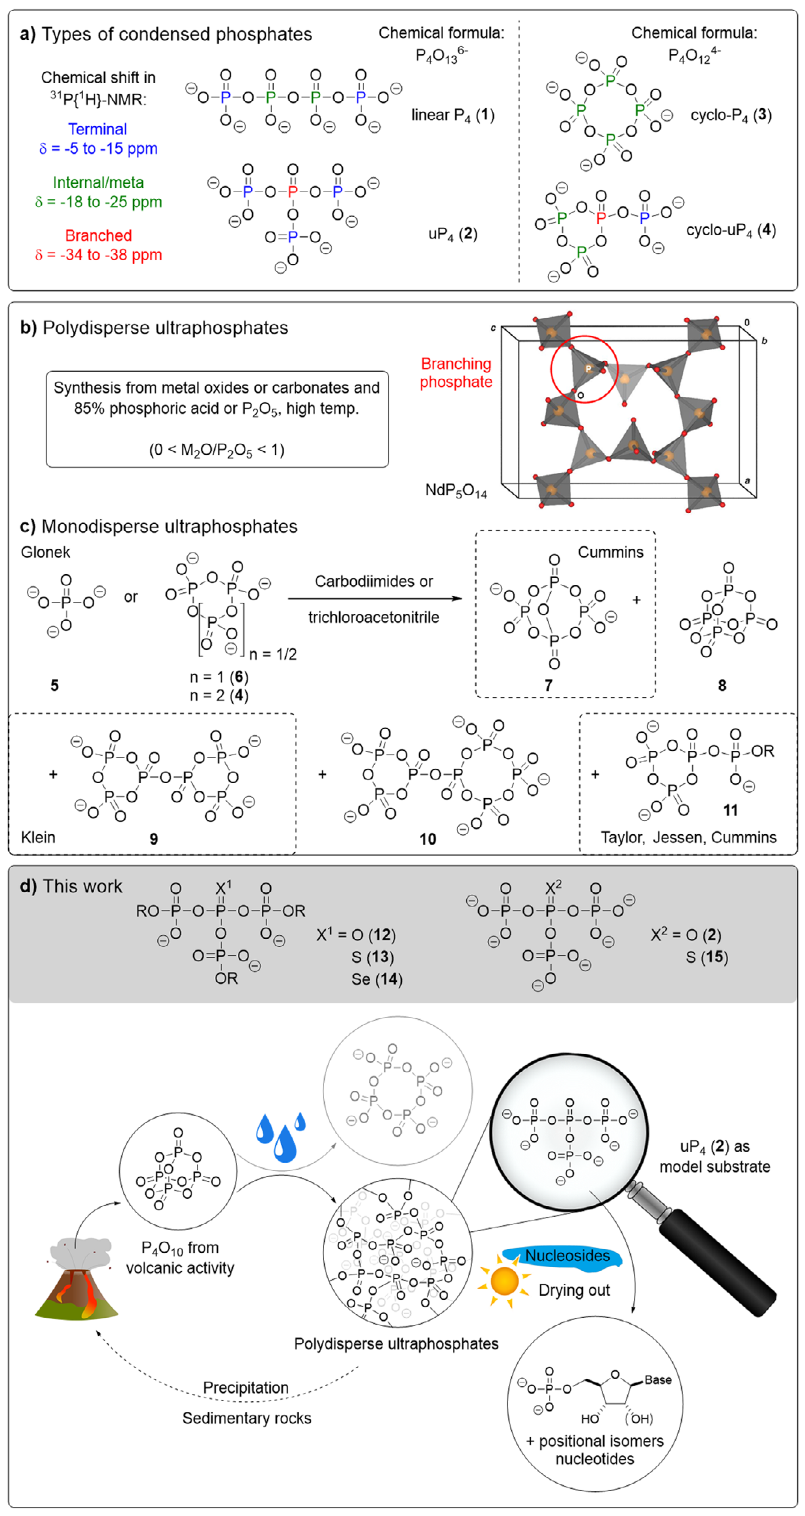
Fig. 1 Previous work on cyclic ultraphosphates and non-cyclic ultraphosphates in this work with implications for prebiotic chemistry. a Types of condensed phosphates and their chemical shift in 31 P{ 1 H}-NMR. b General synthesis protocol for polydisperse ultraphosphates and crystal structure of NdP 5 O 14 61 . c Monodisperse ultraphosphates detected by Glonek in the condensation reactions of orthophosphoric acid or metaphosphates using carbodiimides or trichloroacetonitrile 24 – 28 . The structures in dashed boxes were further described in publications by Klein 62 , Taylor 29 , Jessen 31, 32 and Cummins 33 . d General structures of ultraphosphates in this work and suggestion for prebiotically plausible phosphorylation reactions using ultraphosphates: uP 4 ( 2 ) was used as a model substrate for polydisperse ultraphosphates arising from reactions of P 4 O 10 in the presence of water 59 . The prebiotic phosphate cycle including phosphorus pentoxide from volcanic activity has already been proposed and meets the challenge of making phosphate available from low-solubility minerals 56 – 58, 63 .